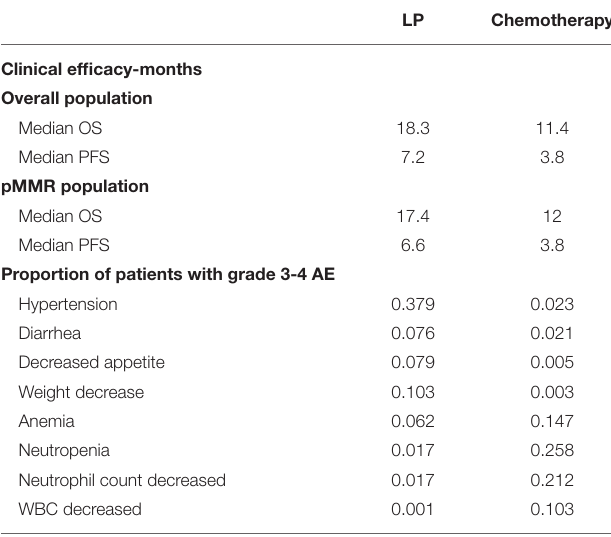
TABLE 1 | Clinical efficacy and proportion of patients with grade 3–4 adverse events.